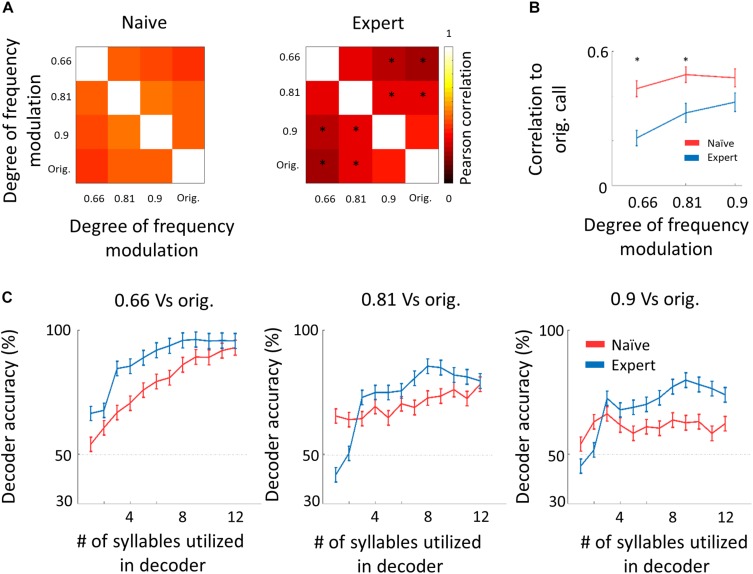
Decorrelation improves coding. (A) Matrices describing the average response similarity of individual neurons between all combinations of stimuli in naïve (left) and expert (right) mice. Each pixel indicates the average Pearson correlation value calculated from all syllables’ evoked spike rate from all neurons to two different calls. Neurons from expert mice have lower correlation between responses to different modulated calls (asterisks indicate significant differences between naïve and expert groups; Mann–Whitney U test followed by Bonferroni correction: ∗p < 0.05). (B) Pearson correlation between responses to modulated WCs and responses to the original WC in naïve (red) and expert (blue) mice (mean ± s.e.m.). Correlations are significantly different in the 0.66 and 0.81 modulation (Mann–Whitney U test: ∗p < 0.05). (C) Classification performance of a support vector machine (SVM) decoder. The decoder was tested for its accuracy to differentiate between the modulated WC stimuli against the original WC. The performance of the decoder is shown for neurons from the naïve (red) and expert (blue) groups. Decoder performance is plotted separately for the three different pairs of stimuli. Each point in each graph shows the number of syllables the decoder was trained on and allowed to use. Error bars are SEM for 1000 repetitions of leave-one-out cross-validation.